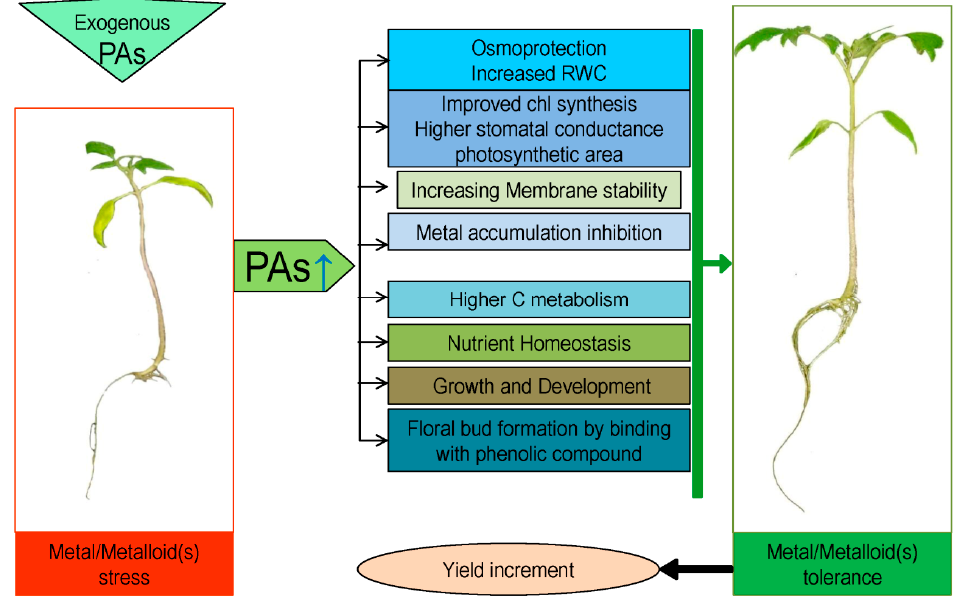
Figure 2. Metal/metalloid(s) stress tolerance by polyamines (PAs). Blue arrow represents the upregulation of PAs accumulation, black arrows represent the enhancement and green arrow represent the tolerance.